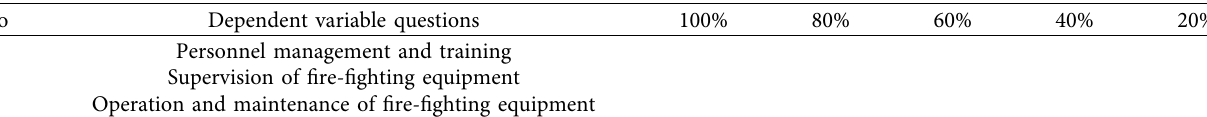
Table 21: Questionnaire feedback of AI fre-fghting facility